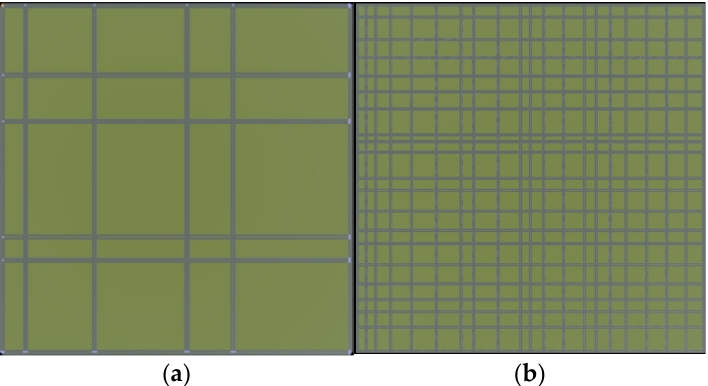
Figure 16. Two road networks were constructed, and the length of each road was randomly set. ( a ) A road network containing 6 roads in horizontal and vertical directions. ( b ) A road network containing 21 roads in horizontal and vertical directions.